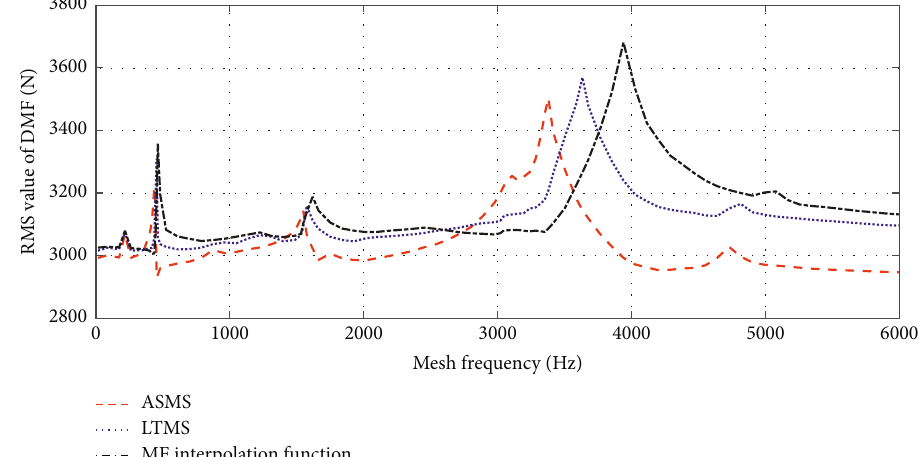
Figure 20: RMS values of the DMF acting on each tooth pair evaluated by the approaches using the ASMS, LTMS, and mesh force interpolation function at 300 Nm toque load.